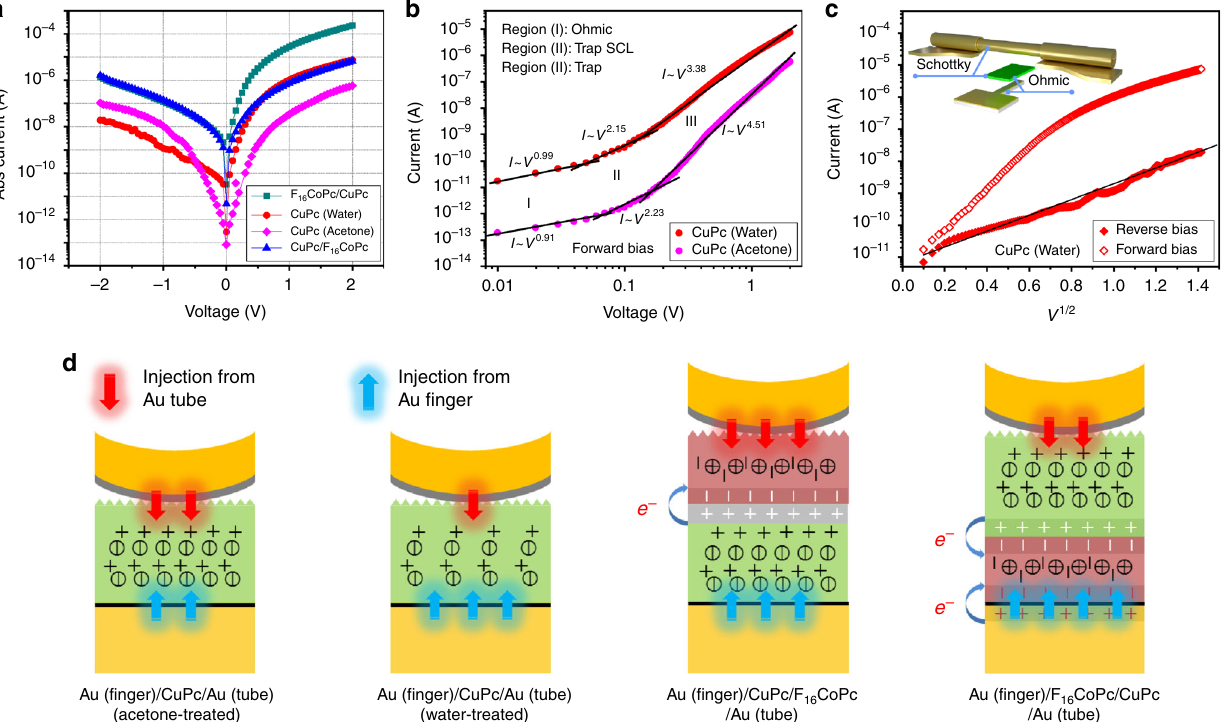
Fig. 4 Origination of the rectifying behavior. a I – V characteristics of the diodes based on acetone- and water-treated CuPc (7 nm), F 16 CoPc (1 nm)/CuPc (7 nm), and CuPc (7 nm)/F 16 CoPc (1 nm), respectively. The mesa widths of all the four cases are 10 μ m. b Log – log plot of the I – V curves of diodes based on acetone- and water-treated Au ( fi nger)/CuPc (7 nm)/Au (tube), showing three regimes distinguished by different m in I – V m . c log( I ) – V 1/2 plot of the I – V curves of diode based on water-treated Au ( fi nger)/CuPc (7 nm)/Au (tube). The inset illustrates the contacts among bottom fi nger electrode, CuPc spacer, and top tube electrode. d Carrier injection from Au tube and fi nger in fl uenced by acetone/water treatment, organic heterojunction